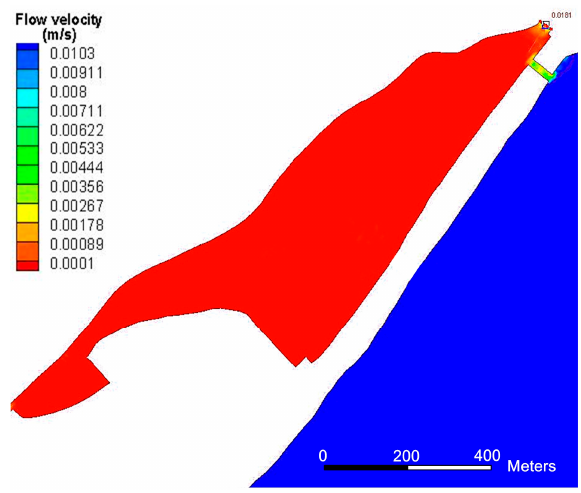
Figure 6. Flow field of Beili Lake prior to the water diversion and distribution project (20 September 2010, provided by the Hangzhou Municipal Xihu Lake Administration Office).